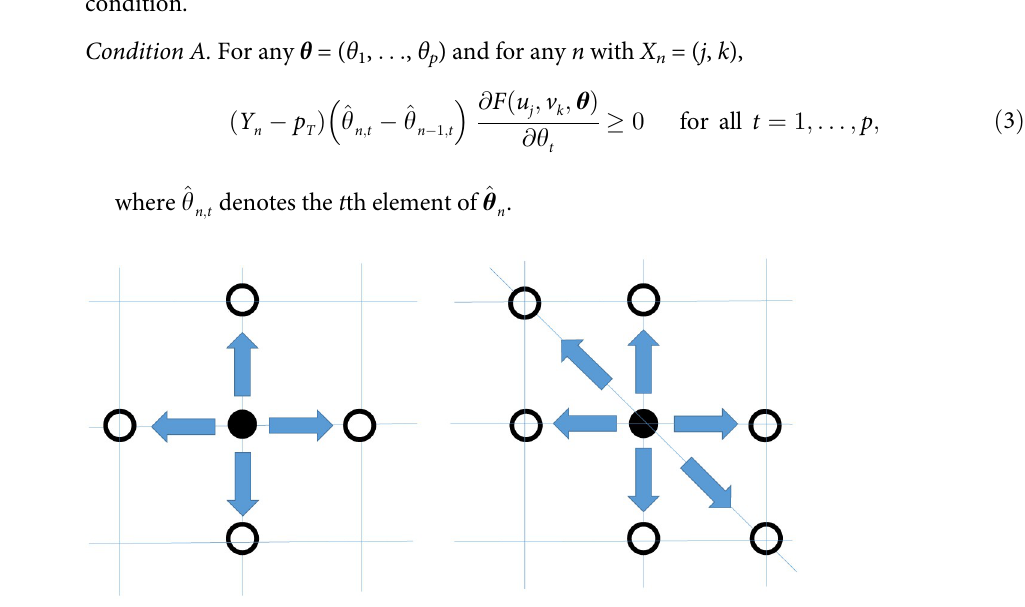
Fig 1. (a) ND-design, which does not allow for diagonal dose movement, and (b) D-design, which allows for diagonal dose movement. The filled circle indicates the current dose combination; the empty circles denote the candidate doses for escalation and de-escalation under the given